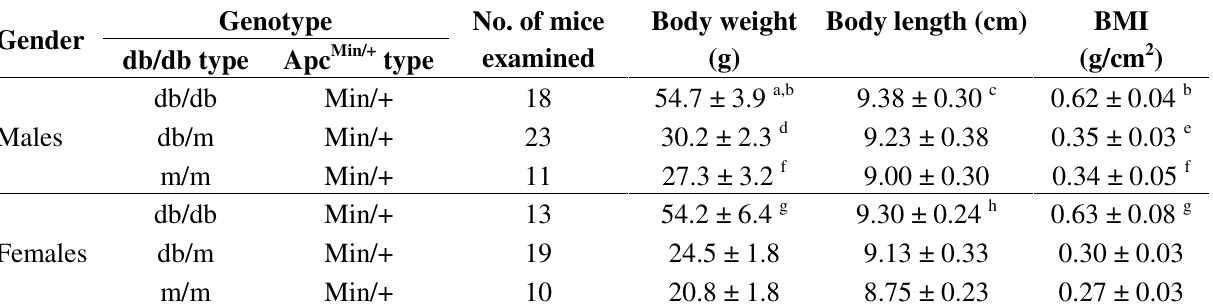
Table 1. Body weight, body length and BMI of mice at 15 weeks of